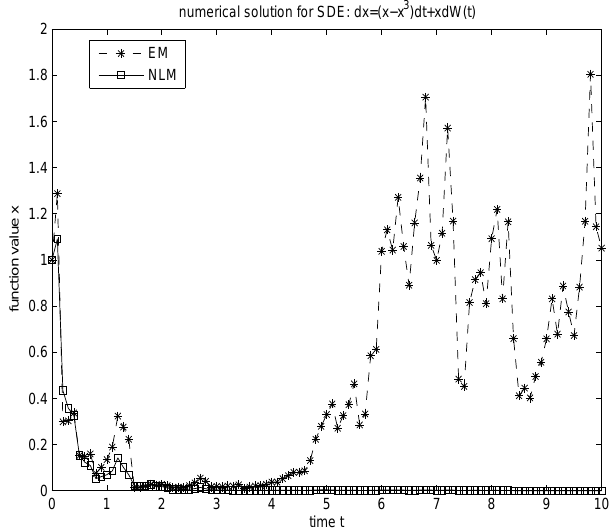
Figure 6. Numerical simulation for the equation: dx = ( x − x 3 ) dt + xdW ( t ) . The time interval: [0,10], the stepsize: dt = 0.1, the initial value: X ( 0 ) = 1.